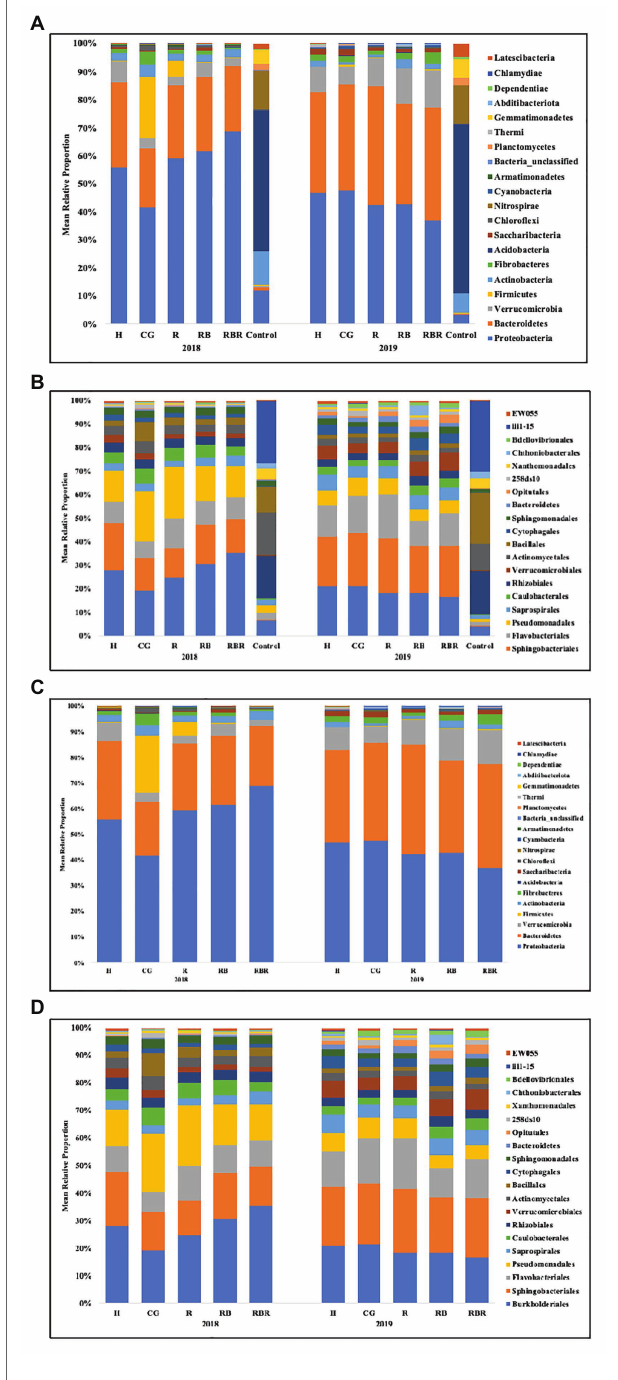
FIGURE 3 | Mean relative proportion of bacterial taxa at the phylum (A) and order (B) level found in runoff (with or without control samples included in the analysis) following long-term conservation pasture management. Treatments included: hayed (H), continuously grazed (CG), rotationally grazed (R), rotationally grazed with a buffer strip (RB), and rotationally grazed with a fenced riparian buffer (RBR). (A) Bacterial community composition at the phylum level found in runoff with control samples. (B) Bacterial community composition at the order level found in runoff with control samples. (C) Bacterial community structure in phylum level found in runoff without control samples. (D) Bacterial community structure in order level found in runoff without control